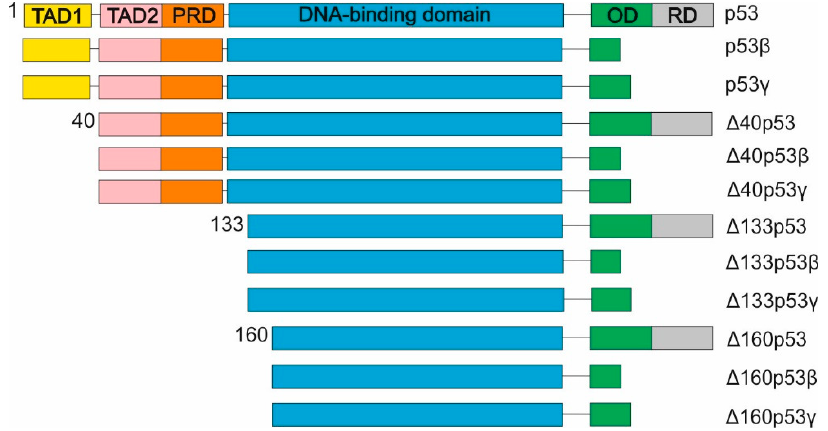
Figure 4. Human p53 isoforms. Twelve p53 isoforms are expressed from Tp53 gene. There are four p53 isoforms differ from N-terminus (p53, Δ 40p53, Δ 133p53 and Δ 160p53). Each of them possesses a distinct C-terminus resulting from different splicing events. The domains are described in Figure 3.